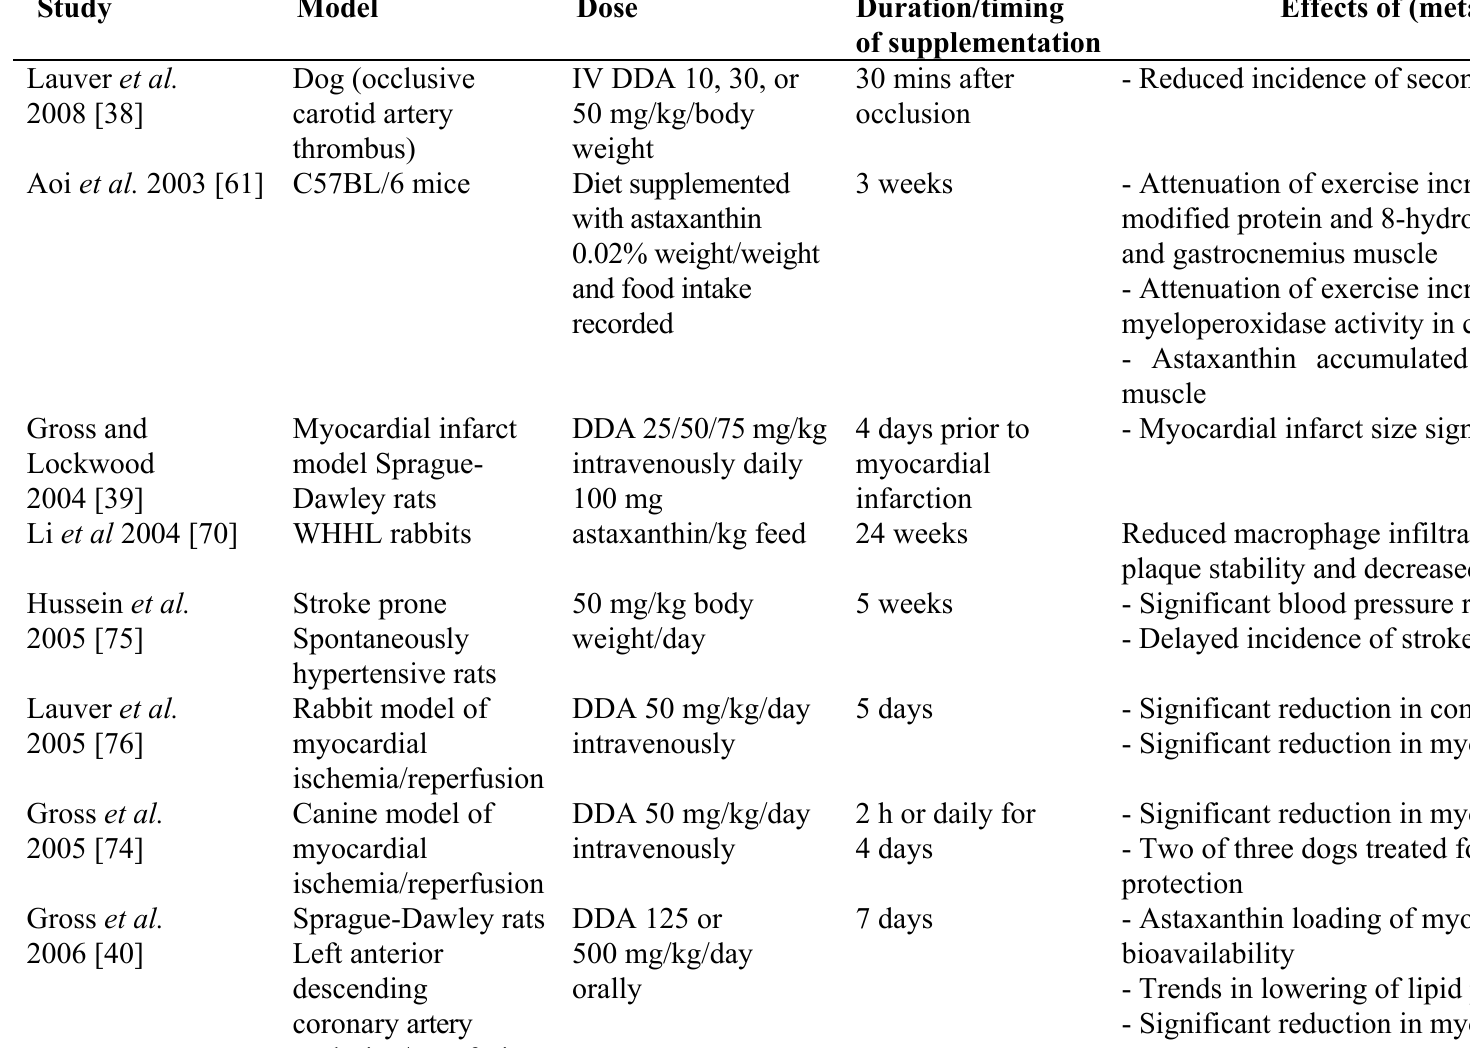
Table 1. Animal investigations of astaxanthin effects related to the cardiovascular